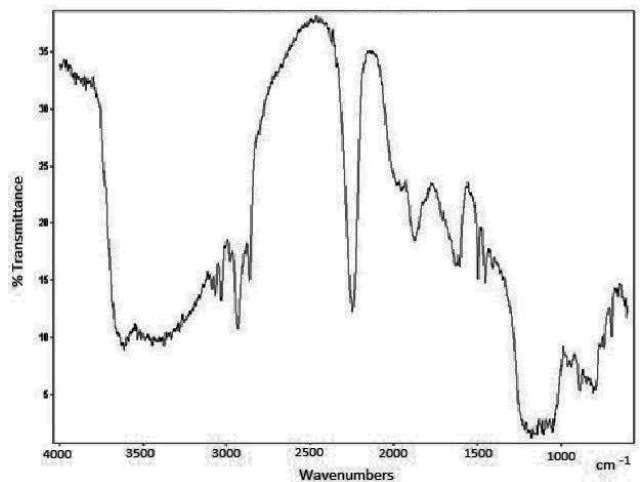
Figure 2. Diffuse reflectance infrared Fourier transform (DRIFT) spectrum of a butyl phenyl moiety bonded to a silica hydride surface.